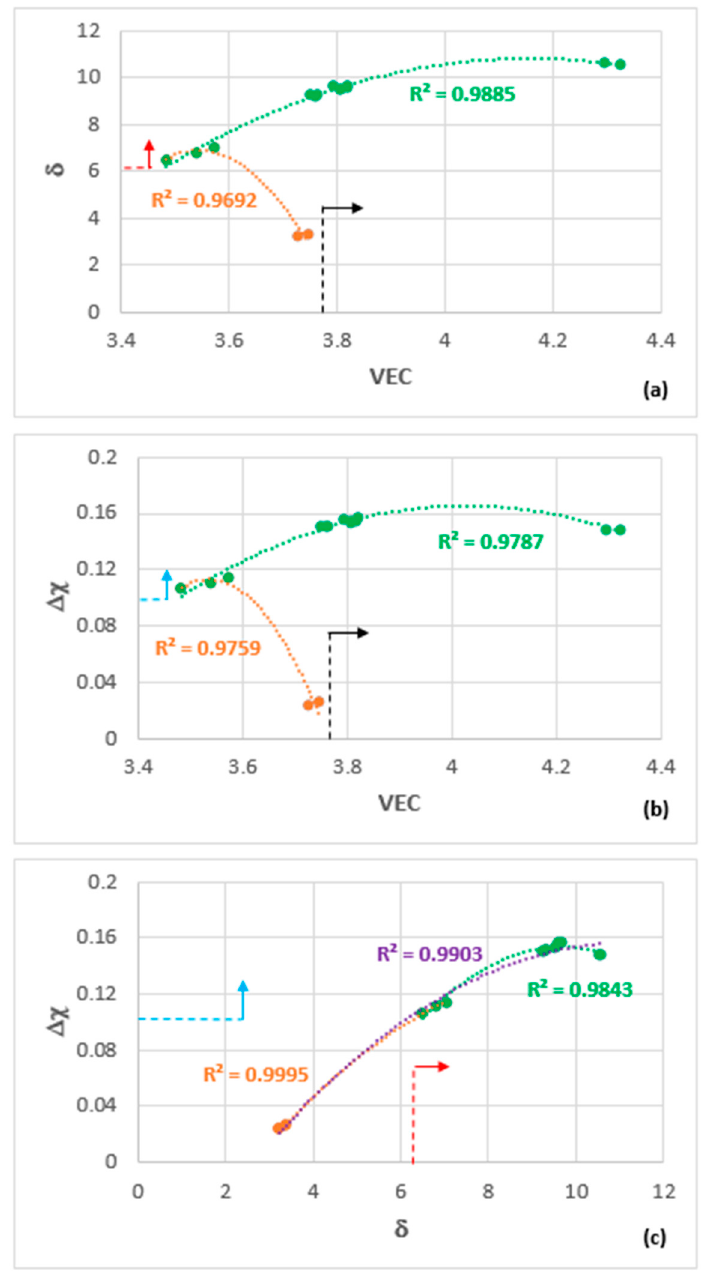
Figure 11. Maps of the parameters δ , ∆ χ , and VEC (number of valence electrons per atom filled into the valence band). Green colour for the alloys OHC5, MG5, MG6, MG7, Zone A of MG7, orange colour for the alloy OHC3, see also Figure 13 ( a ) δ versus VEC, ( b ) ∆ χ versus VEC, ( c ) ∆ χ versus δ . In ( c ) the purple fit (R 2 = 0.9903) is for all the alloys. For arrows and dashed lines see text.